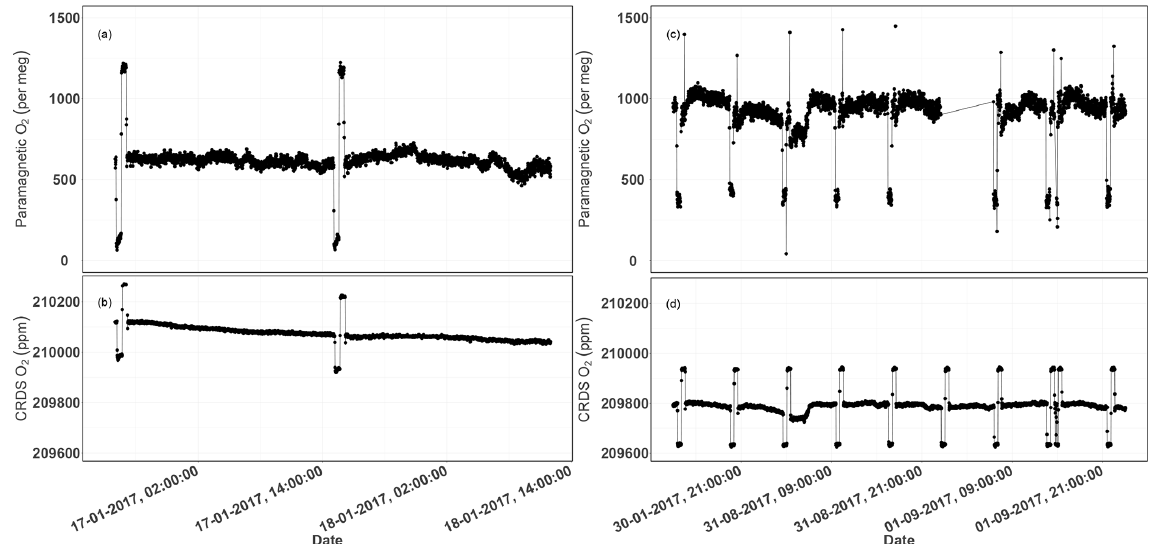
Figure 13. Parallel ambient air measurements from the paramagnetic and CRDS analyzers at the beginning of the testing period ( a, b , January 2017) and the second phase of testing ( c, d , September 2017). The spikes are measurements from the two standard gases bracketing the ambient air values.